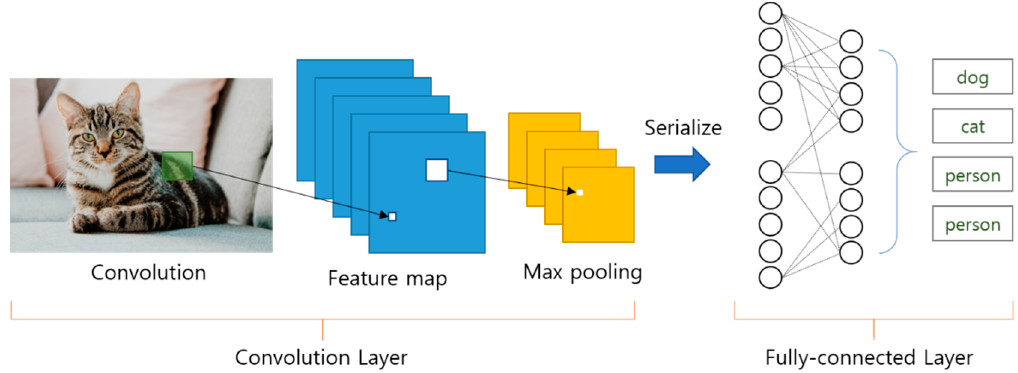
Figure 4. General Convolutional Neural Network structure for image classification.